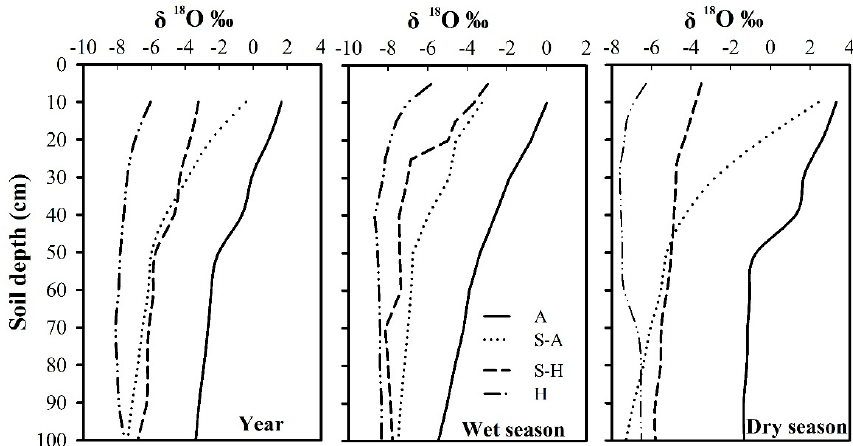
Figure 2. Seasonal dynamics of the δ 18 O values in soil water (0–100 cm). A: Arid region; S-A: Semi-arid region; S-H: Semi-humid region; H: Humid region.